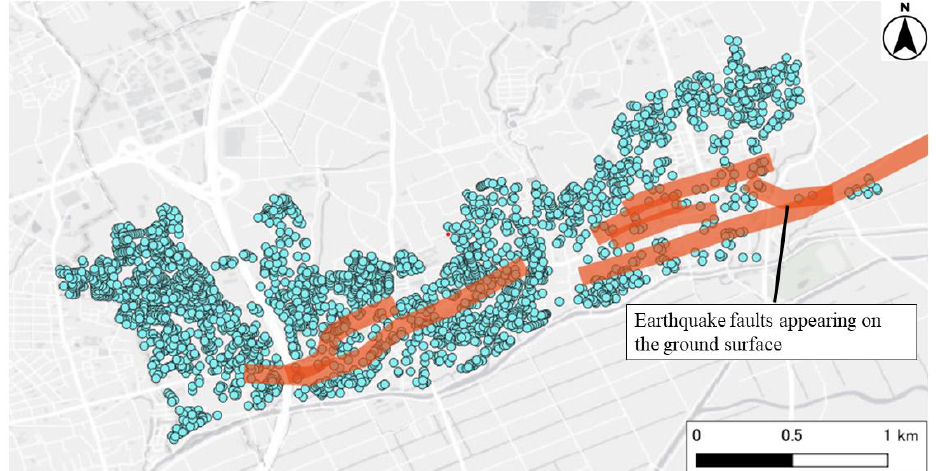
Figure 7. Distribution map of the buildings categorized as Minor damage and the earthquake faults in Mashiki Town (blue dots indicate the Minor damage buildings, and red lines indicate the earthquake faults). Building points and the earthquake faults are plotted on the map provided by ESRI.